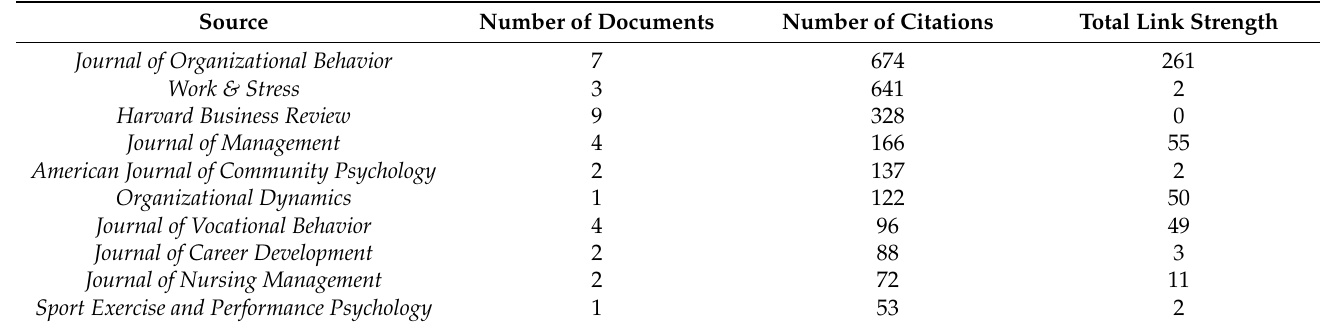
Table 3. Highly cited journals in the topic of thriving at work organized by several citations.